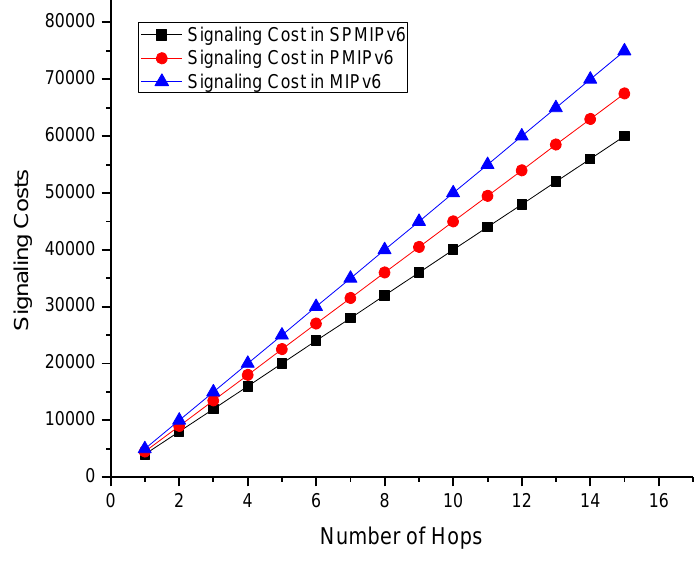
Figure 10. Number of Hops vs. Signaling Cost.